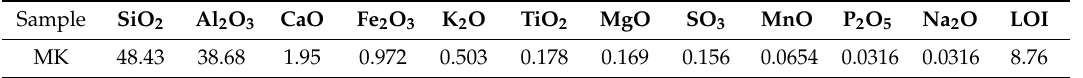
Table 1. Chemical compositions of raw materials by XRF analysis (mass,